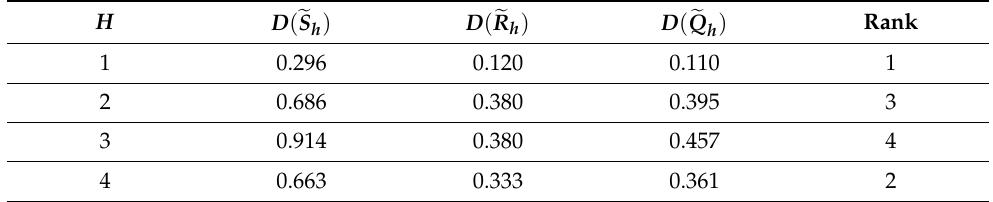
Table 8. Defuzzification results.